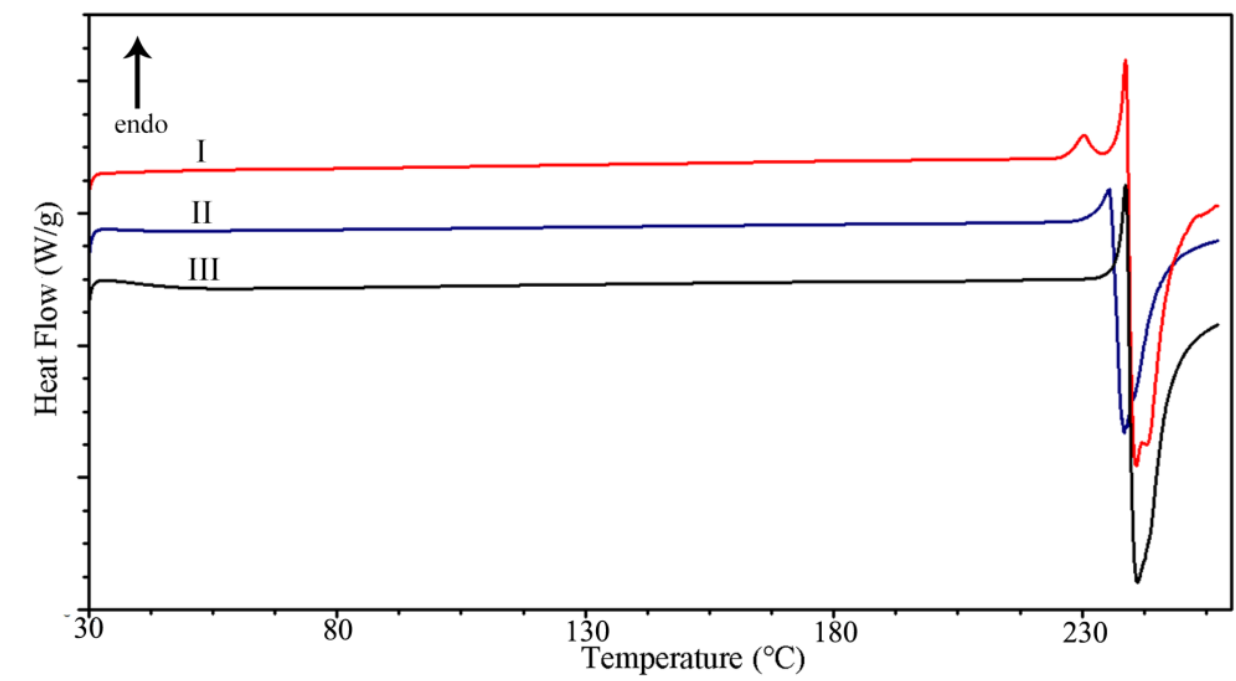
Figure 5. DSC curves of BXM in Form I, Form II, and Form III at a 10 °C/min heating rate.